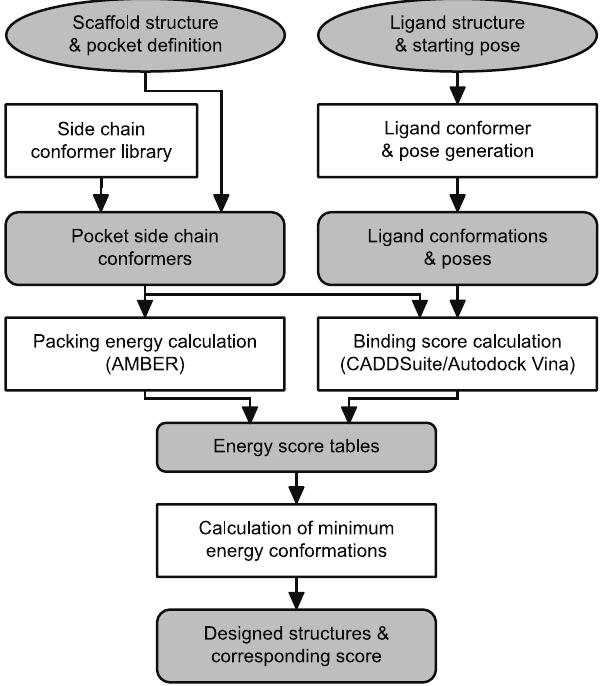
Figure 1. Workflow of PocketOptimizer. The input specific for a design is depicted in circles, parts of the pipeline are shown in pointed rectangles, and output components in rounded rectangles. The output is stored in standard file formats (SDF and PDB for structural data, csv for energy tables). This allows the easy replacement of a component with another that solves the same task (e.g. replacing the binding score function).